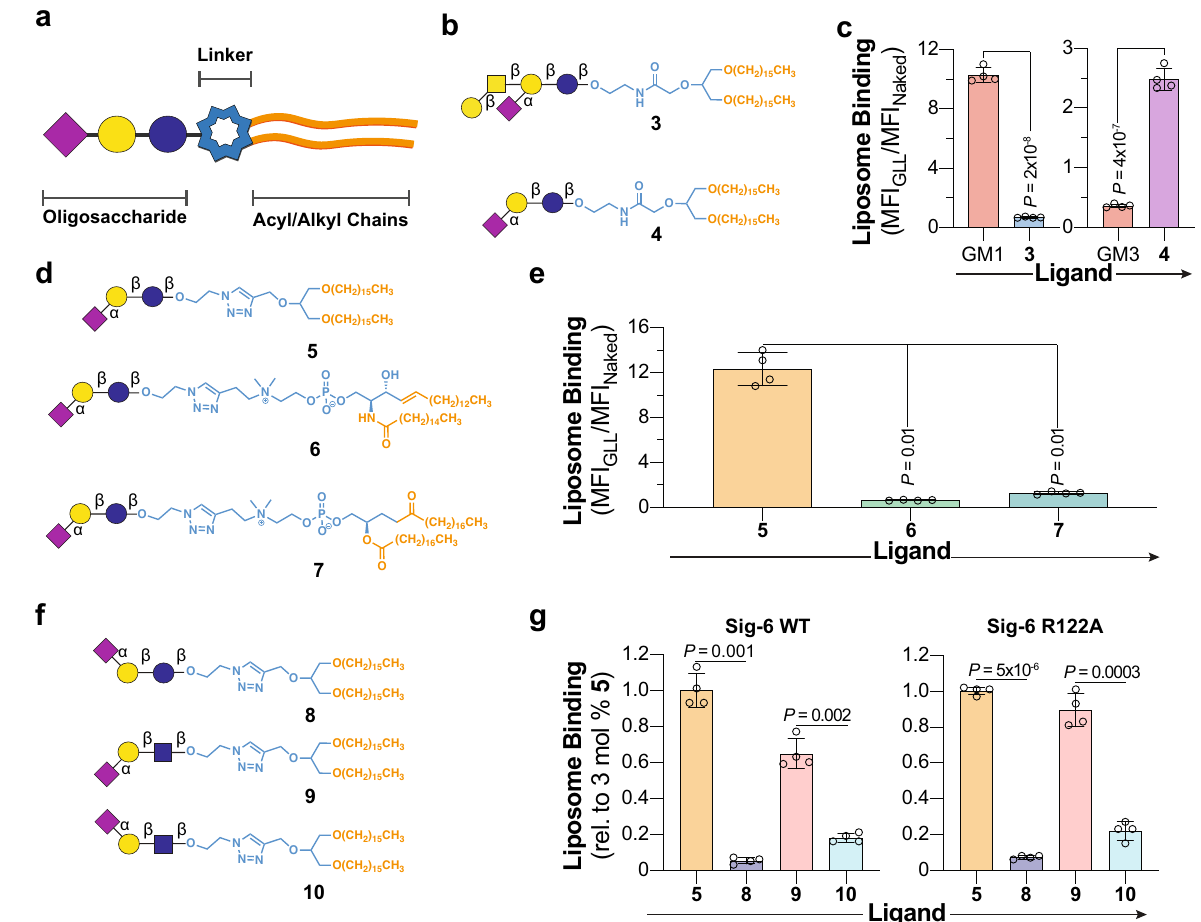
Fig. 3 | Exploring the glycolipid binding speci fi city of Siglec-6 using nGLLs. a Schematic of a glycolipid structure broken down into three components. b Structures of nGLs 3 and 4 presenting the oligosaccharide of GM1 and GM3, respectively, through an amide-linkage to a 1,3-di- O -hexadecyl glycerol scaffold. c Bindingofliposomesformulatedwith3mol% 3 and 4 toWTSiglec-6CHOcellsin the cell assay, relative to liposomes formulated without a ligand ( n =4 technical replicates). d ,StructuresofnGLs 5 , 6 ,and 7 presentingtheoligosaccharideofGM3 triazole-linked to 1,3-di- O -hexadecyl glycerol, phosphatidyl sphingomyelin, and distearoylphosphatidylcholine scaffold, respectively. e Binding of liposomes for- mulated with nGLs 5 , 6 , and 7 to WT Siglec-6 CHO cells in the cell assay relative to